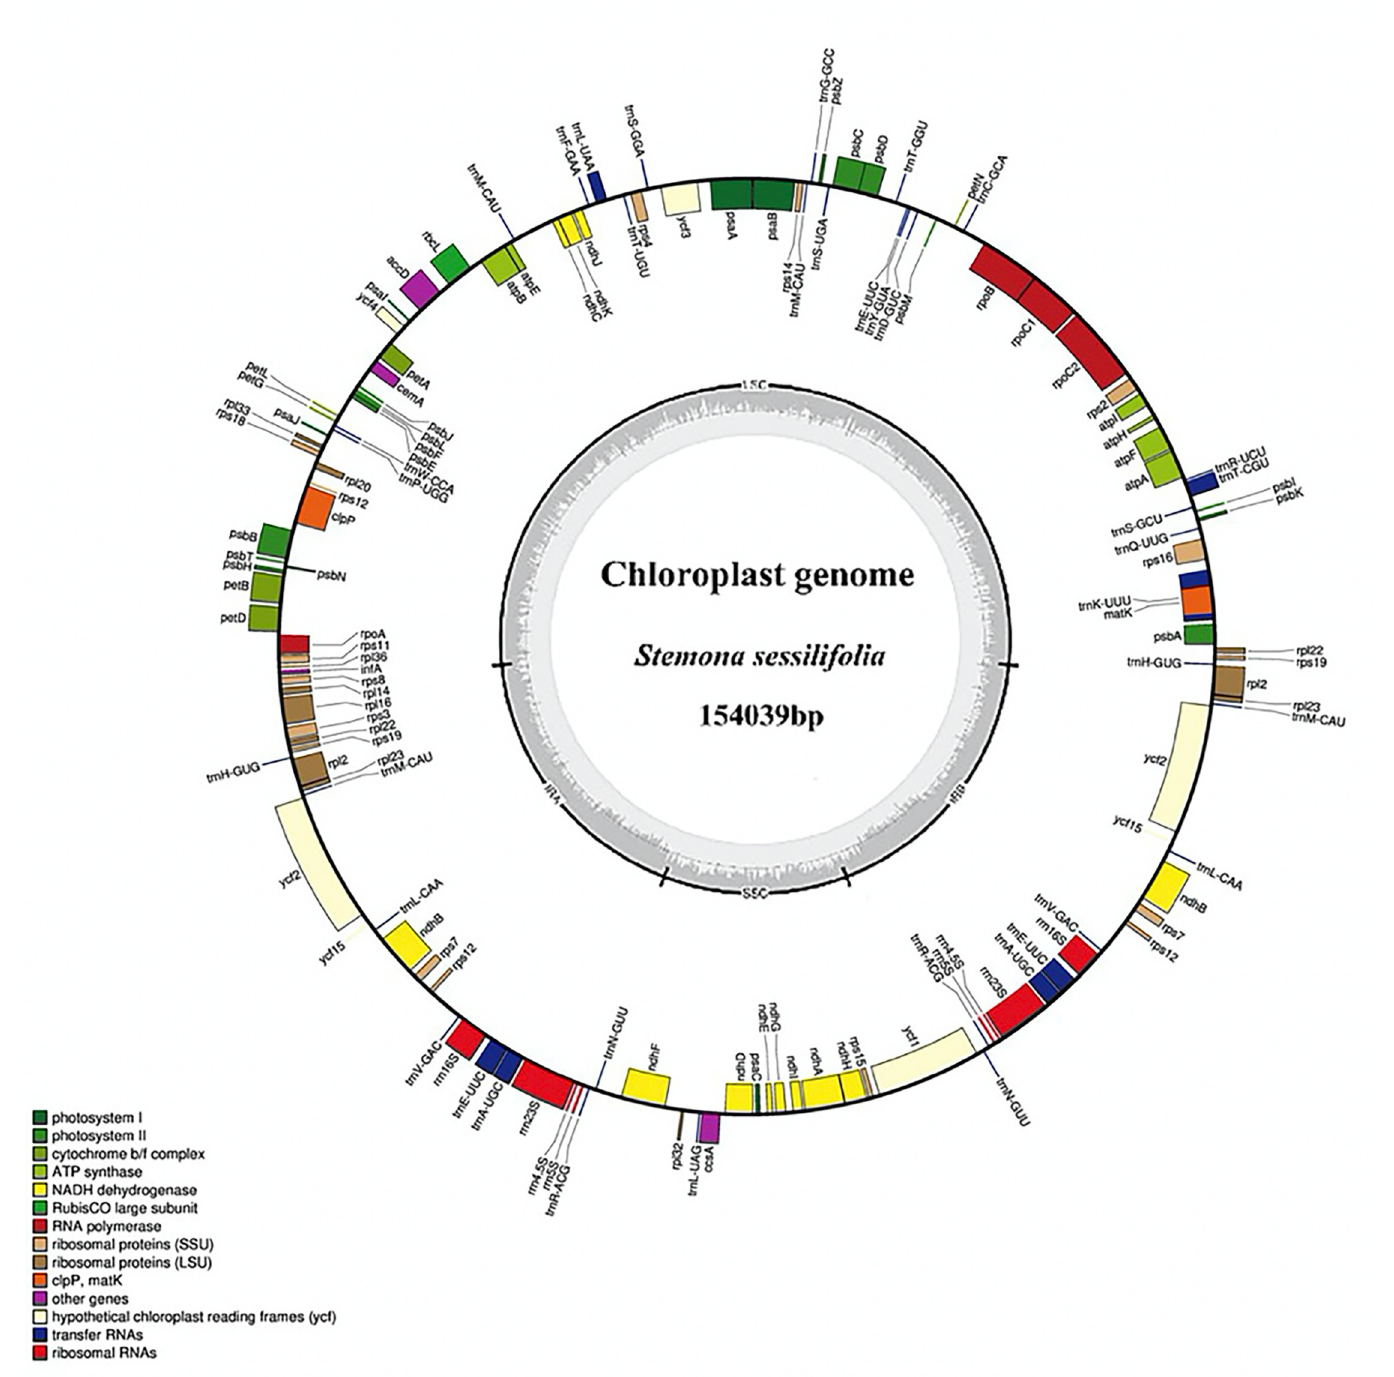
Fig 1. Gene maps of the chloroplast genomes of Stemona sessilifolia . Genes inside and outside the circle were transcribed clockwise and counterclockwise, respectively. The darker gray in the inner circle indicates the GC content. Genes with different functions are characterized with different color bars.